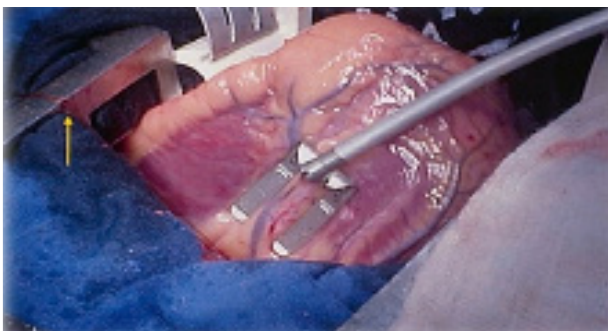
Fig. 12 - Lima suture developed by Dr. Ricardo Lima allowing to perform anastomoses on the posterior wall of the heart and complete